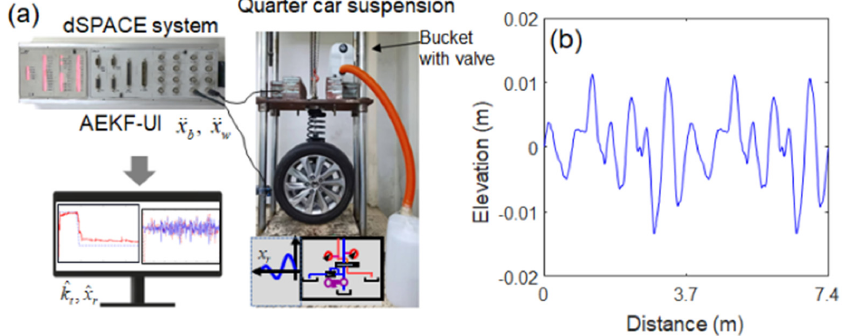
Figure 11. Experimental setup for vehicle mass estimation; ( a ) schematic with a photograph of a quarter car test stand, ( b ) stimulated road roughness input. quarter car test stand, ( b ) stimulated road roughness input.